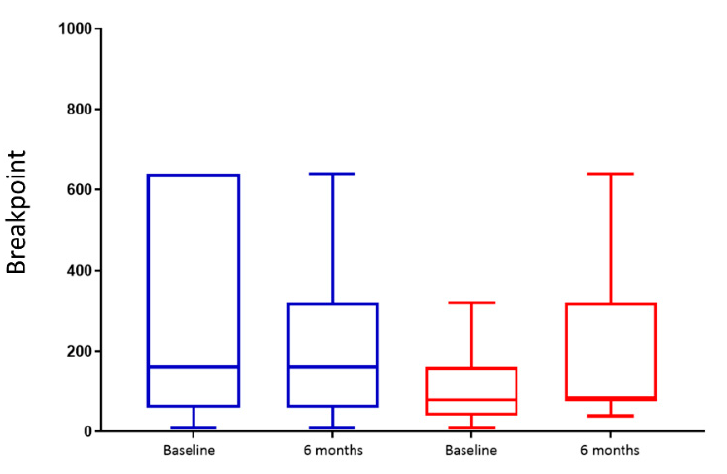
( p = 0.12 for group × time interaction) (Figure 4).